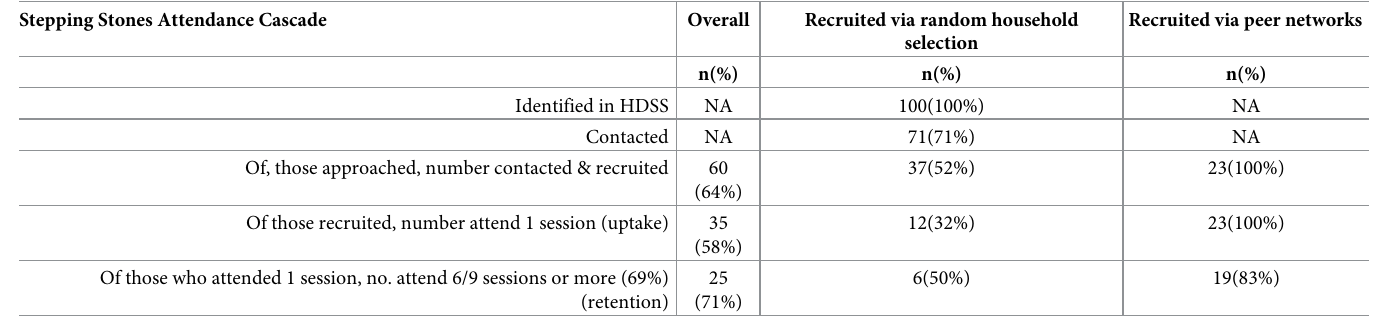
Table 1. Stepping Stones/Creating Futures attendance and retention. Stepping Stones Attendance